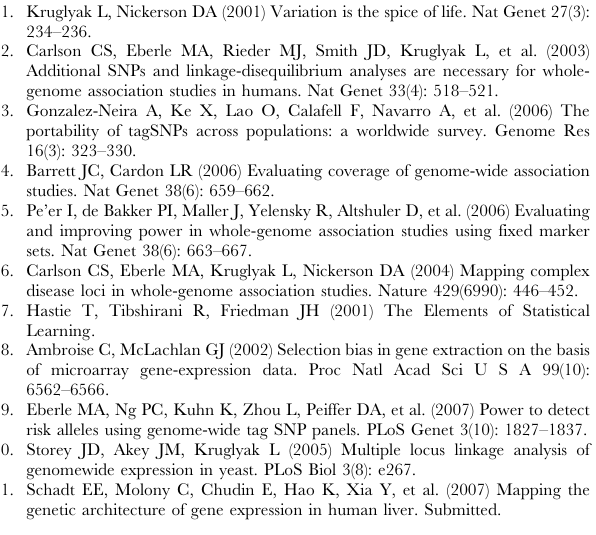
Figure S2 The null distribution of p-values for the Kruskal- Wallis test and Spearman Rank Correlation test. The p-value of Spearman test (p.spearman) follows the uniform distribution under the null, whereas the p-values of the Kruskal-Wallis test shows a lower density in the [0,0.05] range, indicating this test is conservative. Figure S3 Using the expression traits, we surveyed a wide range of p-value cutoffs and the corresponding FDR values for simulated WGAS. Figure S4 (A) and (B): the number of discovery (ND) observed in the expressiongenotype association screening. Please note that one expression trait sometimes showed significant association with multiple mutually proximal SNPs, because these SNPs were in strong LD. (C) and (D): the number of expression traits that showed at least one significant association with SNP(s). Figure S5 The statistical power of the Affymetrix array, Illumina arrays, and ‘‘direct genotyping.’’ (A) SNR = 1/4 and Kruskal- Wallis test; (B) SNR = 1/4 and Spearman rank correlation test; (C)